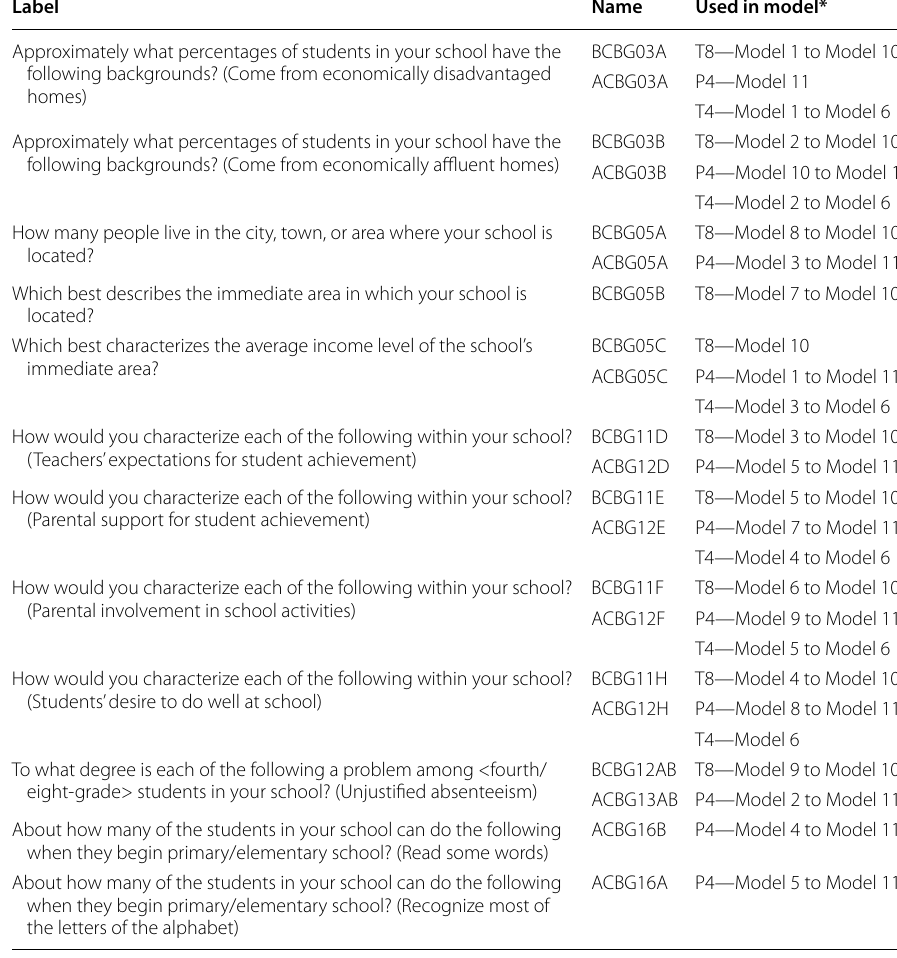
Table 2 School questionnaire variables with cross‑country average correlation coeffi‑ cients r 0.2 with the students’ achievement scores averaged at school ≥ ±